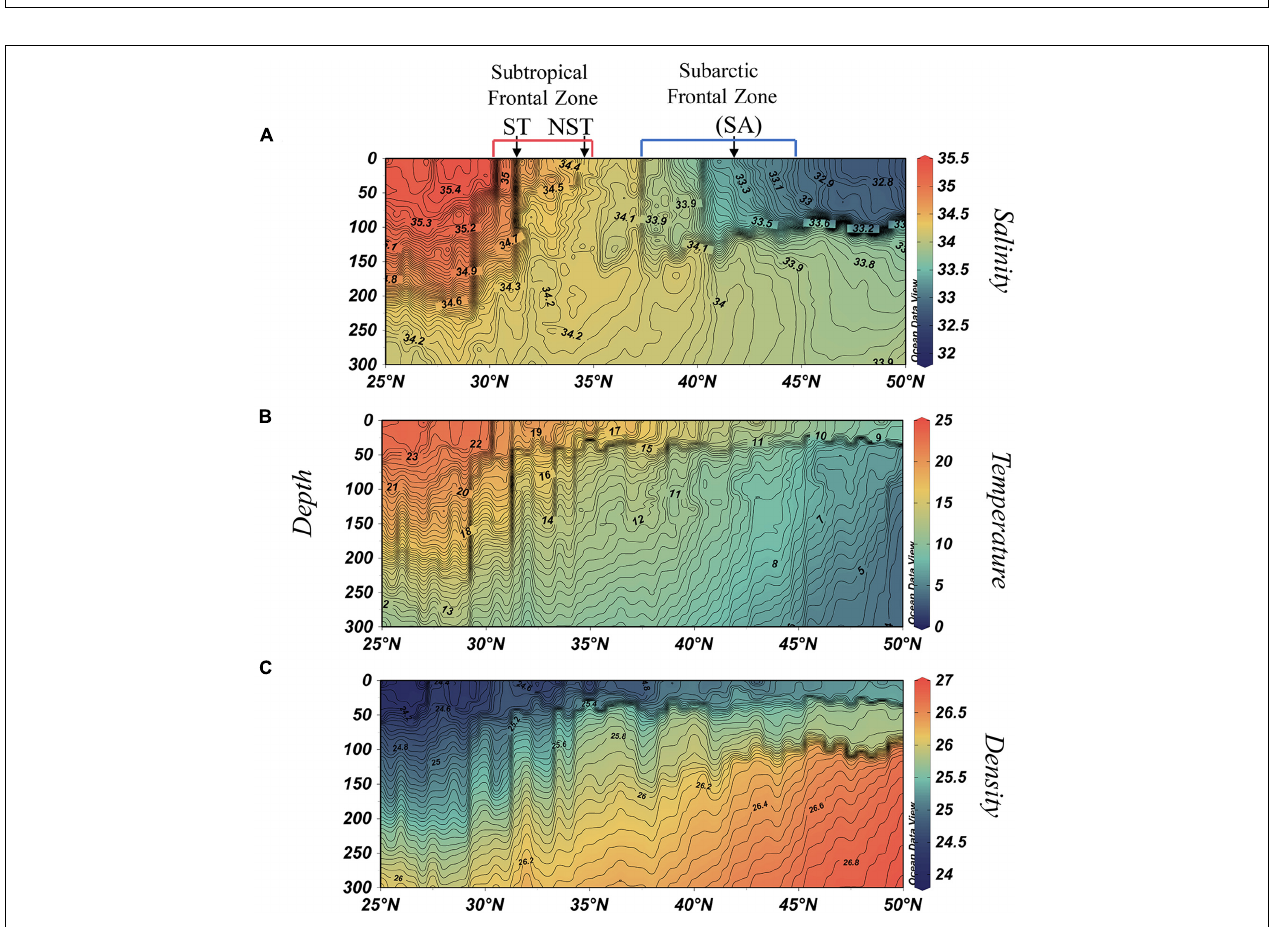
FIGURE 2 | Upper ocean salinity (A) , temperature [ ◦ C] (B) , and potential density [kg m − 3 ] (C) distributions along a section of P16N (25–50 ◦ N, 151 ◦ W), occupied in spring 2015. Contours for isohalines are in 0.025 increments, isotherms in increments of 0.25 ◦ C, and density in increments of 0.02 kg m − 3 .